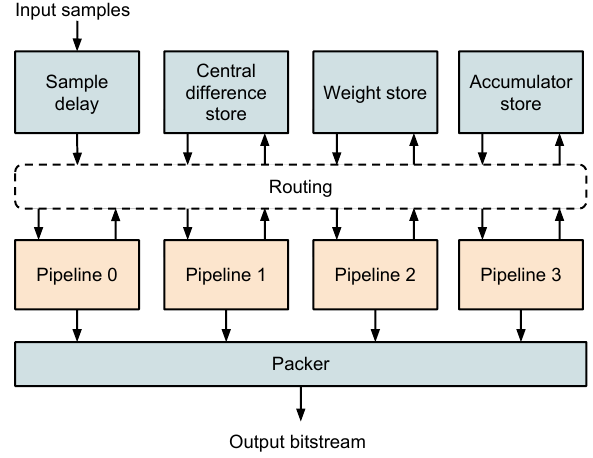
Figure 1. Overview of the parallel CCSDS-123 implementation for N p =